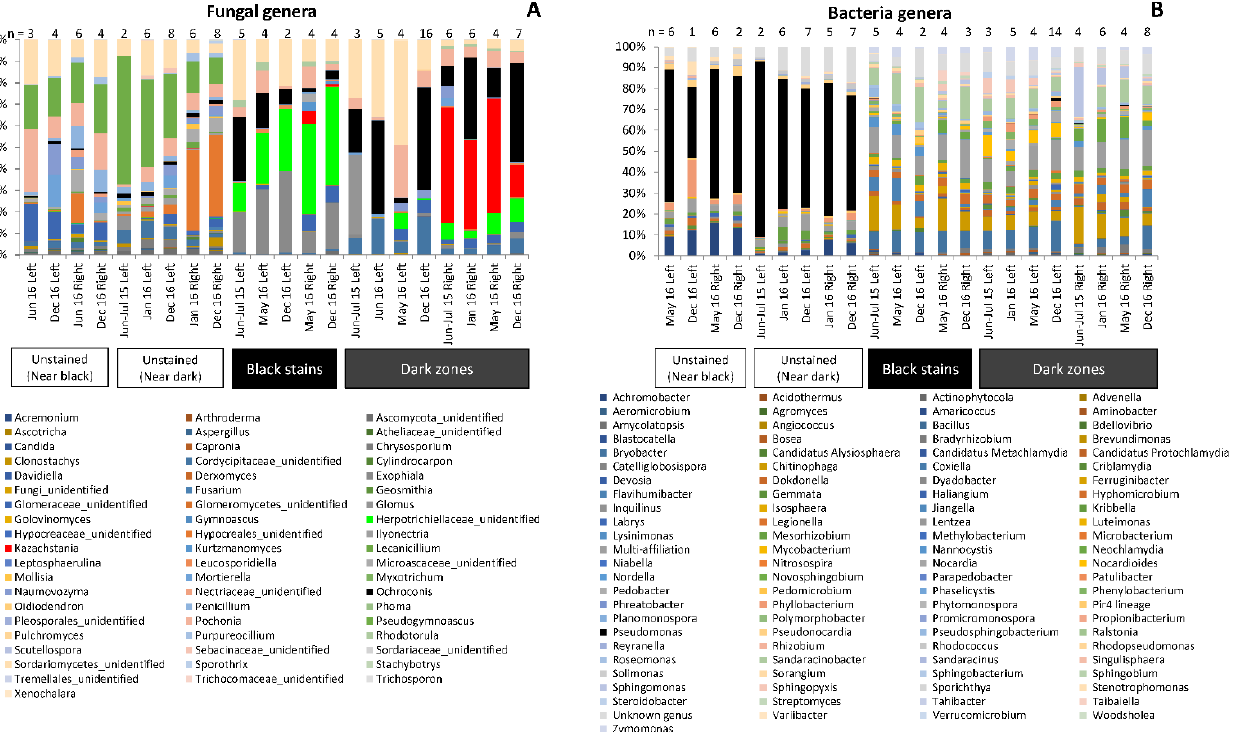
Figure 4. Community composition at genus level for fungi ( A ) and bacteria ( B ) in dark zones (Dark), black stains (Black) and nearby unstained parts (respectively Near Dark and Near Black) sampled from the left (L) and right (R) walls of Lascaux’s Apse in June-July 2015 (15J), January 2016 (16J), May-June 2016 (16M) and December 2016 (16D). Genera representing more than 1% of sequences are indicated. Each histogram is the average from 1–16 samples (indicated in each case). Data used for black stains and their neighboring unstained parts are those from Alonso et al. [10]. Detailed data are reported at Tables S1 and S2.